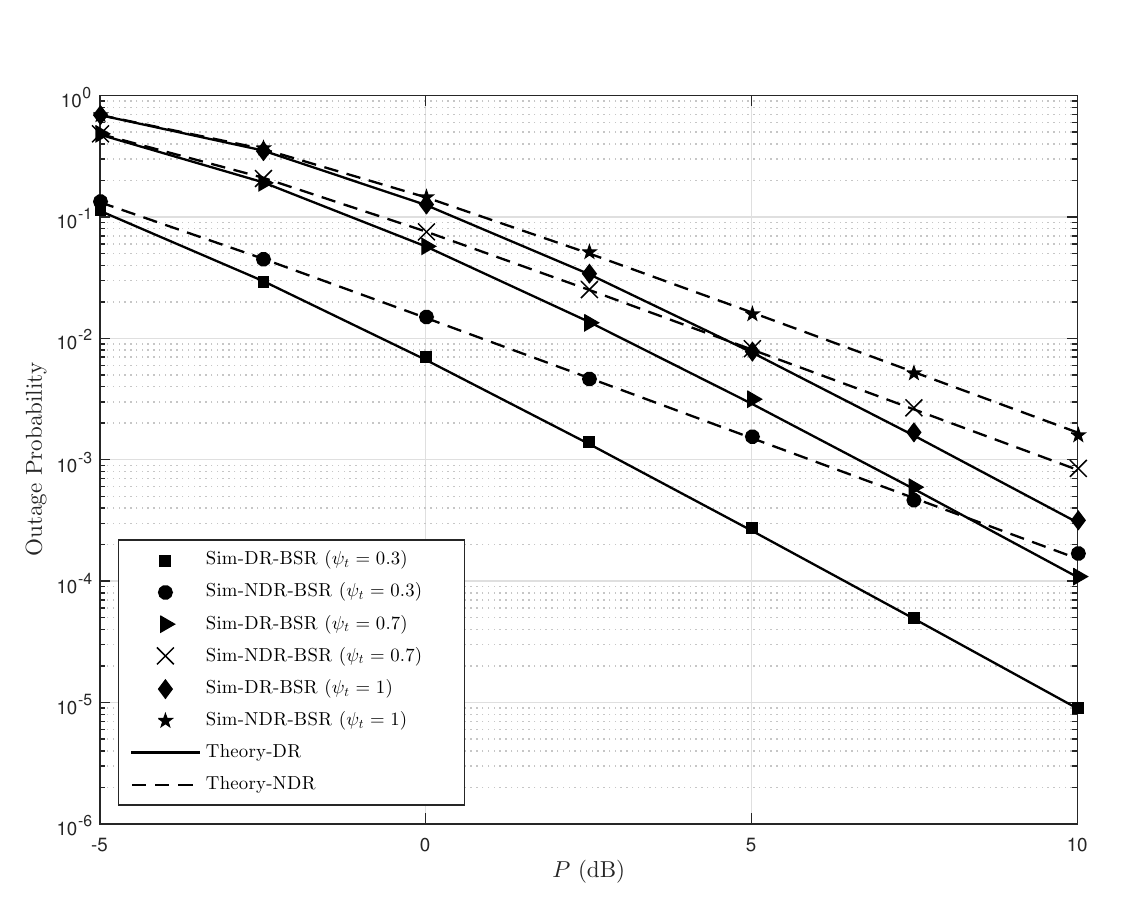
Figure 7. Outage probability versus transmit power P in dB for the DR-BSR and NDR-BSR protocols and for ψ − 0 . 3) , ρ = 0 . 5 , η = 0 . 5 , M = 2 , and N = 2 with ( x , ( x R 1 , y R 1 ) = (0 . 5 , 0 . 3) R 2 , y R 2 ) = (0 . 5 ,